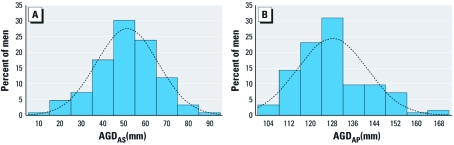
Frequency distributions of AGDAS (A) and
AGDAP (B) in our study population.